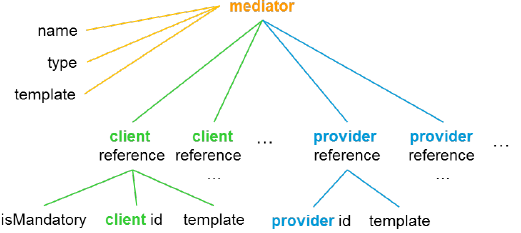
Figure 3: The information that needs to be captured in abstract